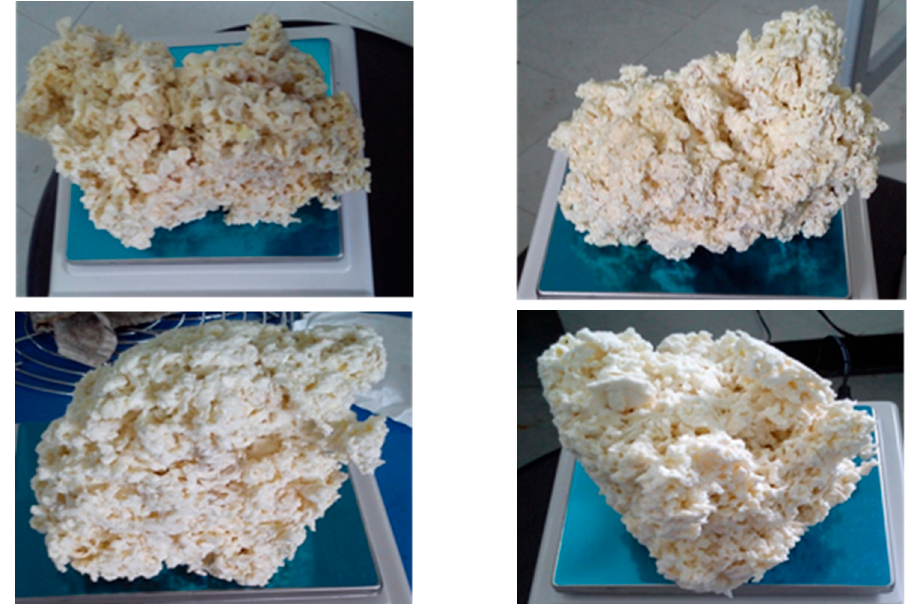
Figure 2. The NR samples ( STR 20 ) supplied from the rubber estate organization ( REO ) of Thailand have a milky colour before drying with a microwave oven . The sample weight is approximately 300 g each .